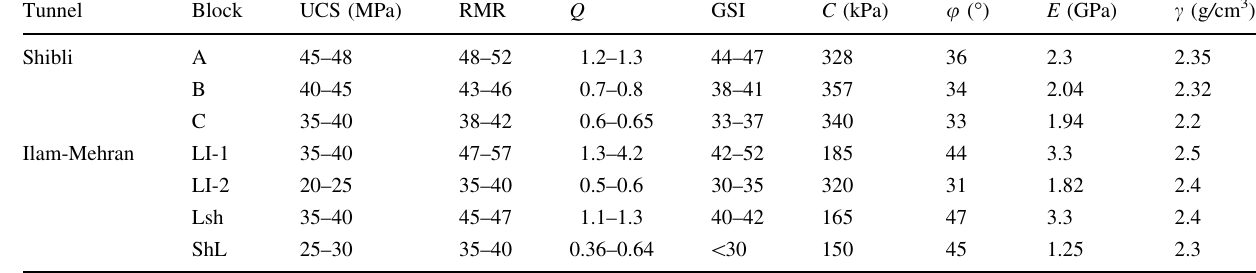
Table 2 Geotechnical properties